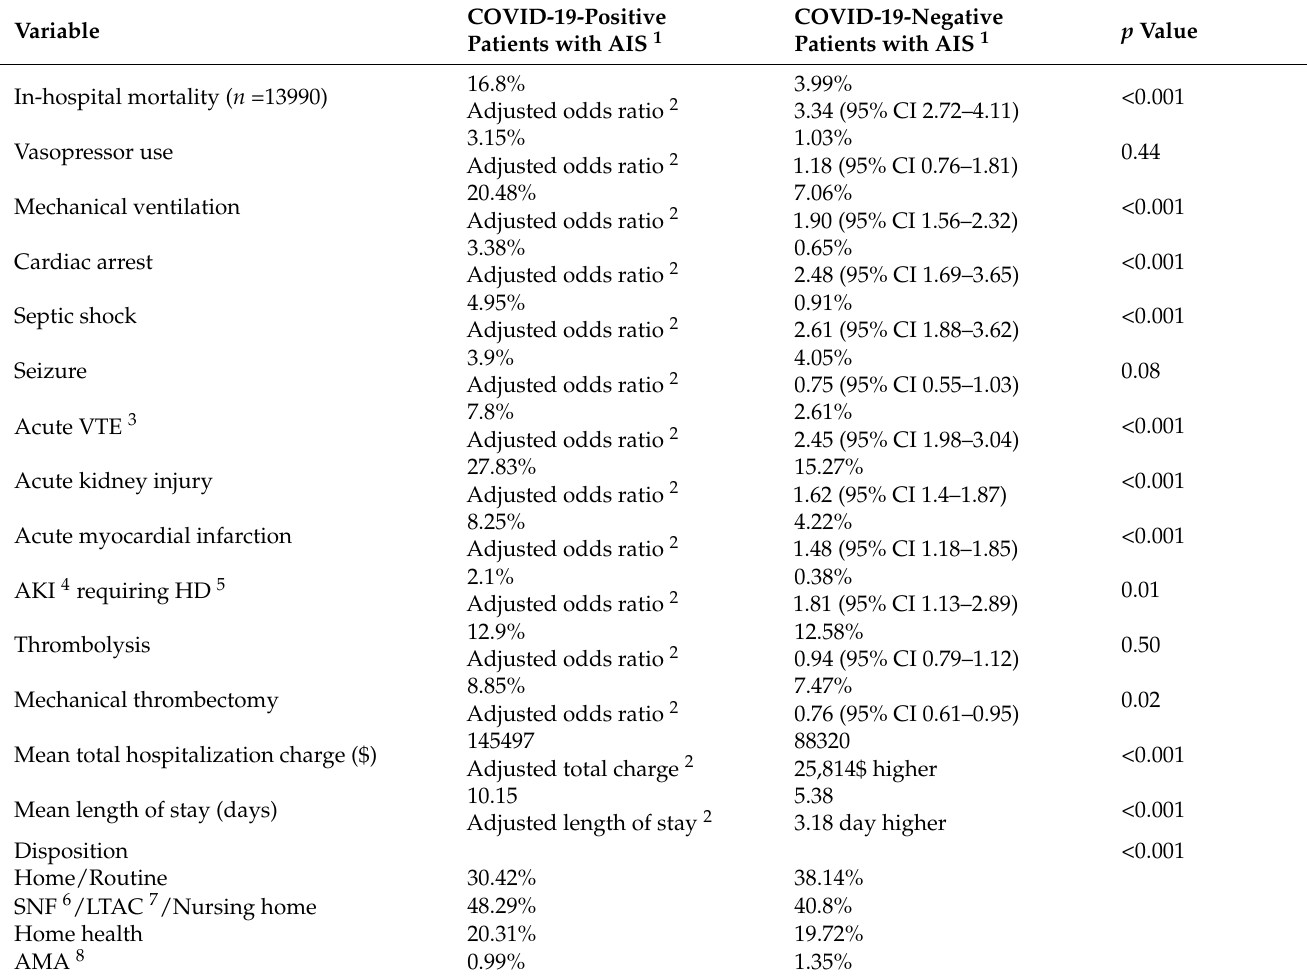
Table 2. In-hospital Outcomes for COVID-19-positive patients with acute ischemic stroke and COVID-19-negative patients with acute ischemic